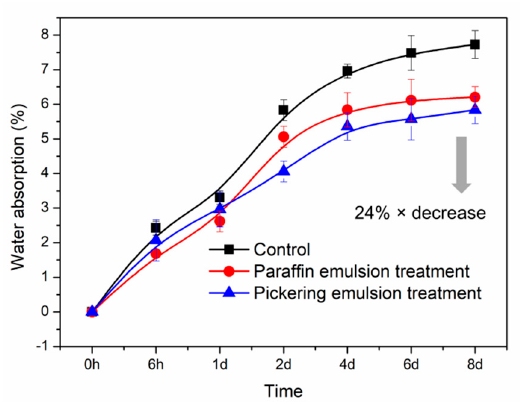
Figure 7. Water absorption of untreated (control) and emulsion treated WF/HDPE composites.